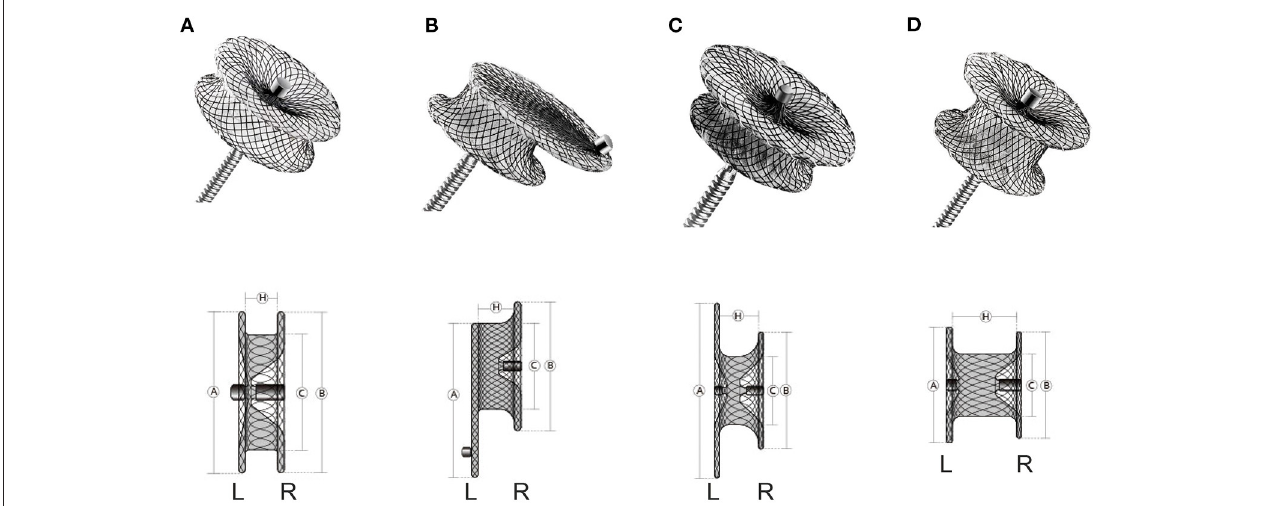
FIGURE 1 | The various occluders and corresponding schematic diagrams. (A) , symmetric occluder. (B) , eccentric occluder. (C) , small-waist occluder. (D) , muscular occluder. L, left; R,